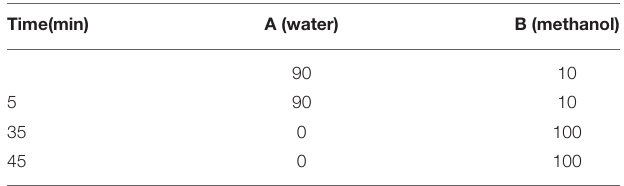
TABLE 2 | Methods of the HPLC analyses for the purities of all of the target compounds.